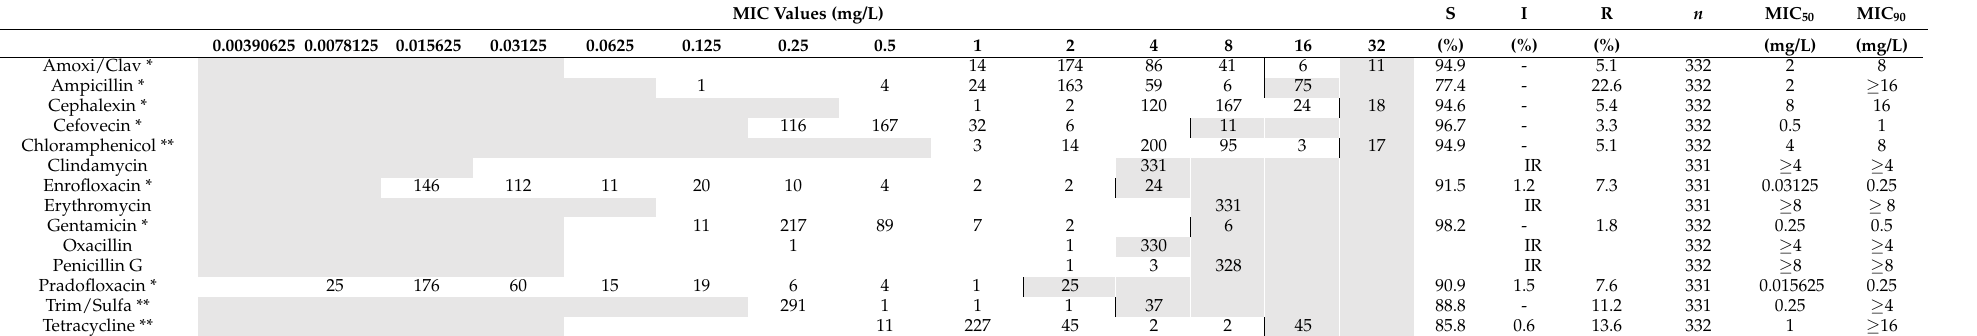
* Indicates that CLSI breakpoints derived from animal breakpoints were used. ** Indicates that CLSI breakpoints derived from human breakpoints were used. S = susceptible, R = resistant, I = intermediate, IR = intrinsic resistance. The dilution ranges tested are those contained in the white area, and values shown above this range are greater than or equal to the concentration shown. Values at the lower end of these ranges are less than or equal to the lowest concentration tested. Where available, breakpoints are indicated by a vertical line. Grey shaded areas indicate concentration of antimicrobial not tested. Amoxi/Clav, amoxicillin/clavulanic acid (2:1); Trim/Sulfa, trimethoprim-sulfamethoxazole (1:19). MICs were determined using standardized agar dilution methodology based upon the recommendation of the